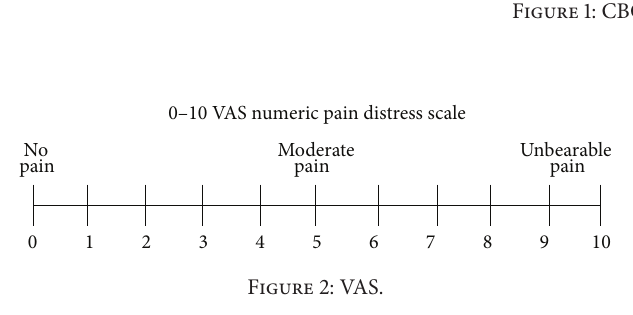
Figure 1: CBCT landmarks.